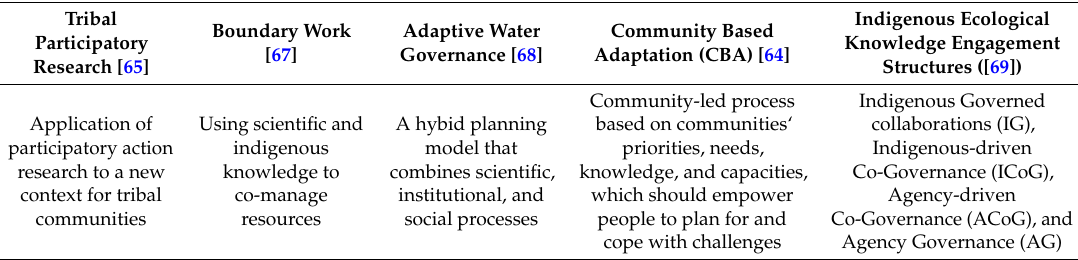
Table 1. Selected five approaches of engaging tribal members, communities, and nations in water management